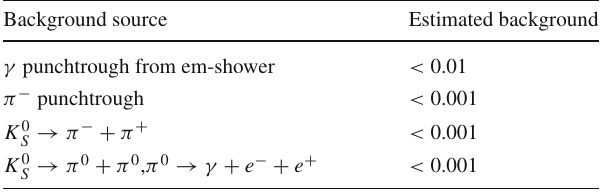
Table 3 Background sources for NA64 visible mode tracking analysis estimated for 3 · 10 10